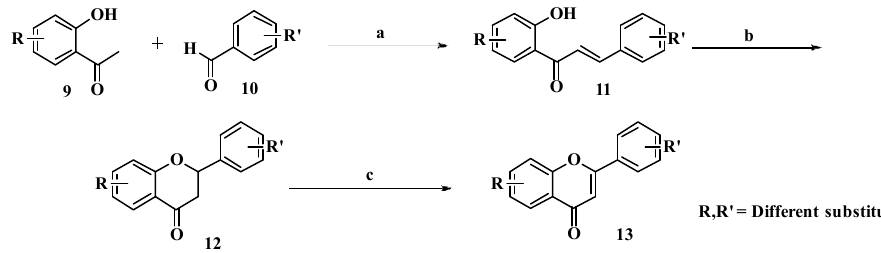
Figure 2. The structures of Series Ⅰ , Ⅱ , Ⅲ compounds.